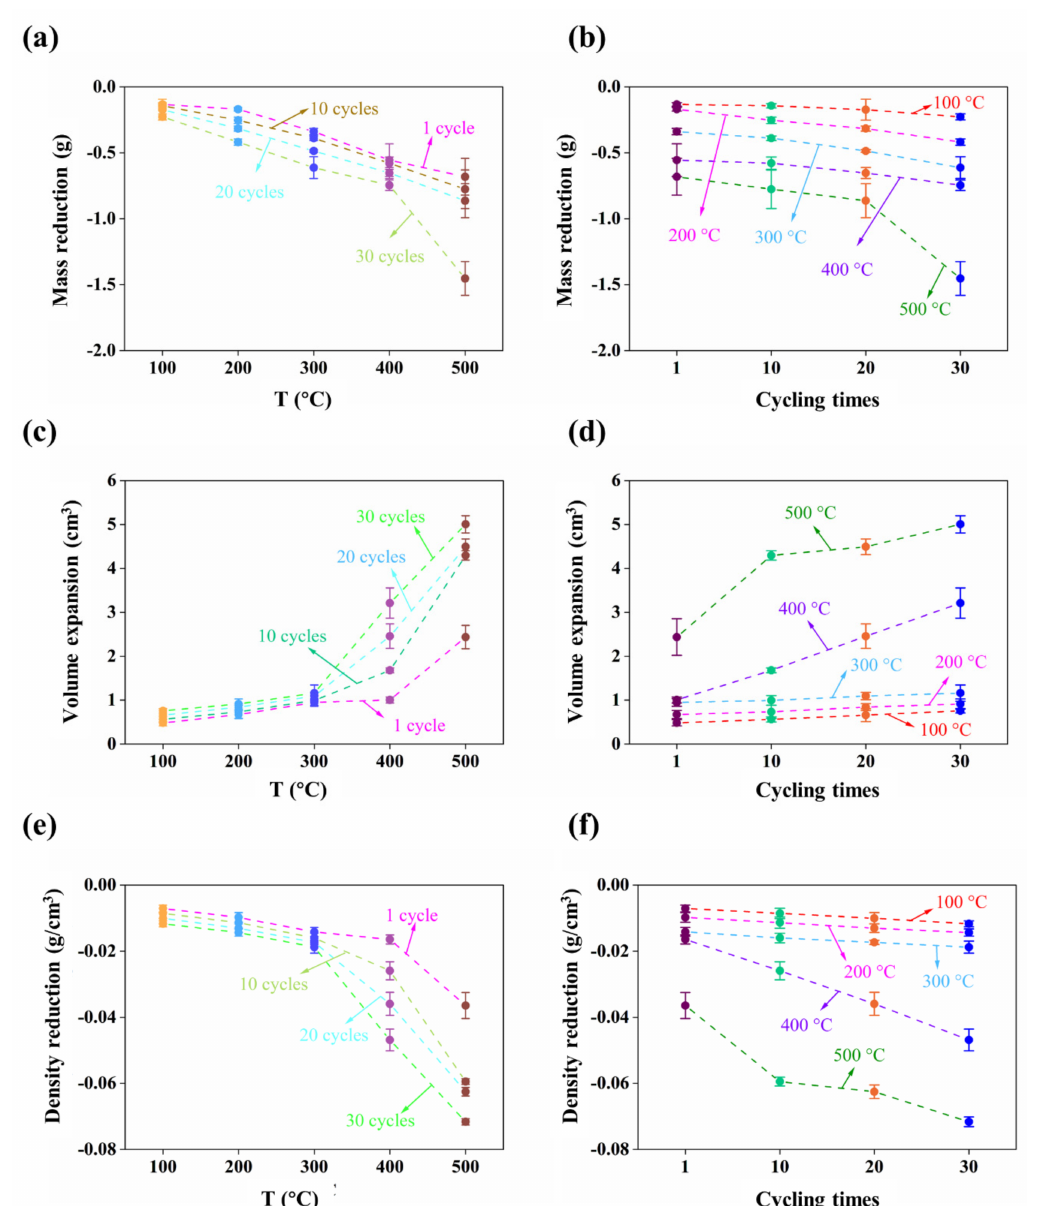
Figure 3. Variation trend of ( a , b ) mass, ( c , d ) volume, and ( e , f ) density of granite induced by thermal cycling